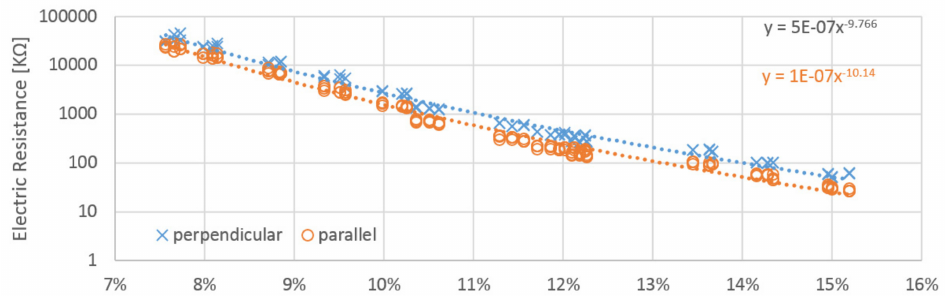
Figure 13. Obtained resistances from the integration and RC methods, the results calculated for the samples at the “A”, “B” and “C” electrodes together for parallel and perpendicular